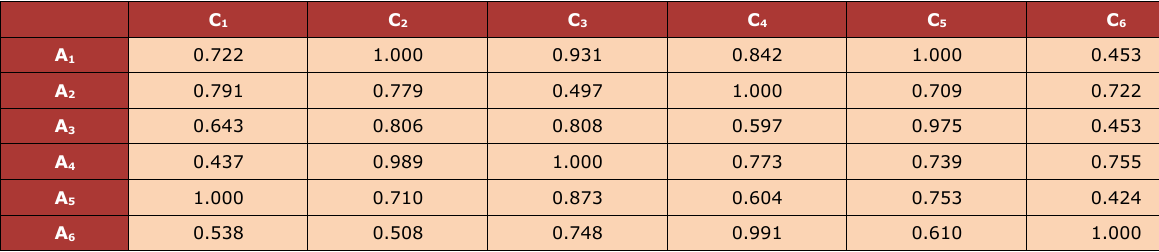
Table 8. Normalized decision matrix